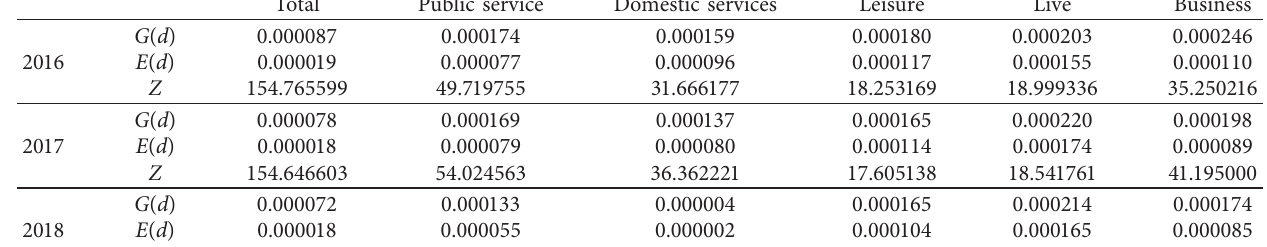
Table 2: Getis-Ord General G index of POI in Guiyang main city from 2016 to 2018.